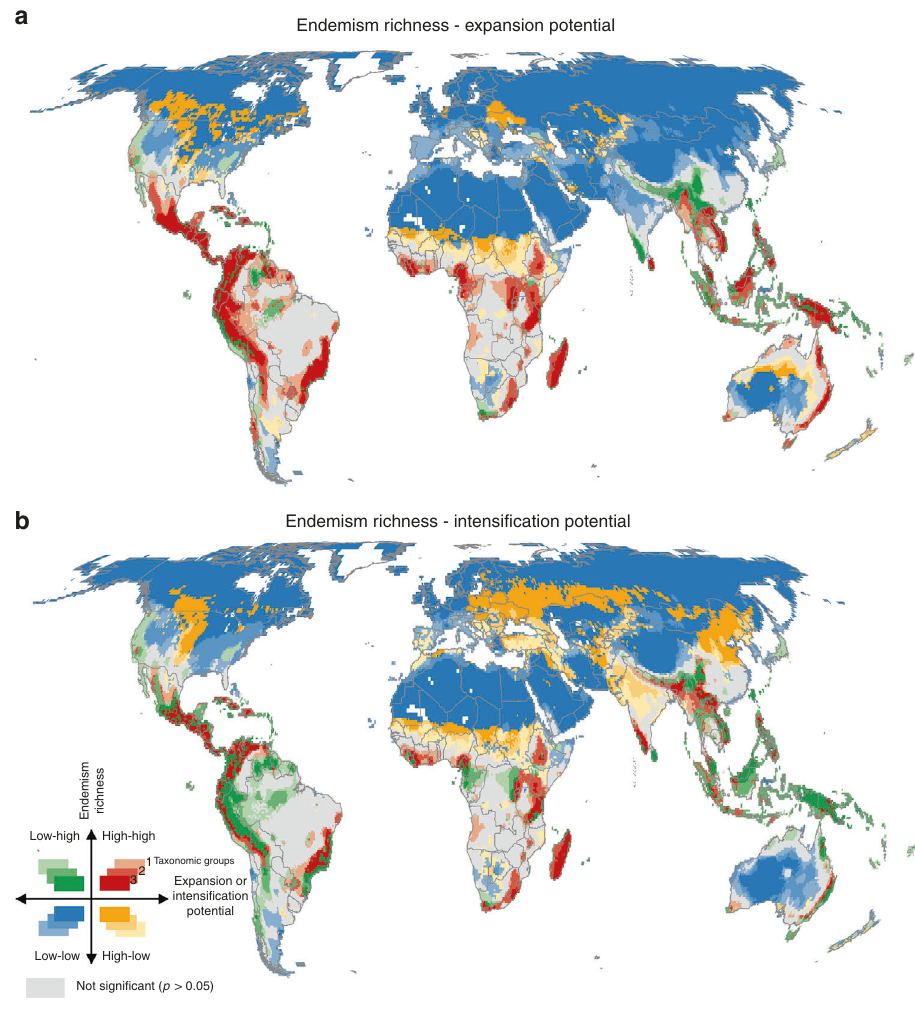
Fig. 3 Spatial association between endemism richness and potentials for a cropland expansion and b intensi fi cation. They are calculated using local indicators of spatial association (LISA) at 55-km resolution. High – high clusters indicate hotspot locations (red), in which areas most suitable for expansion/intensi fi cation of cropland are signi fi cantly associated with high values of endemism richness (at 0.05 signi fi cance level). Low – low clusters (blue) show cold spot locations, in which areas with low potential for expansion/intensi fi cation are associated with low values of endemism richness. High – low and low – high clusters show inverse spatial association. Three shades of colours indicate signi fi cant results for one, two or all three taxonomic groups (birds, mammals,